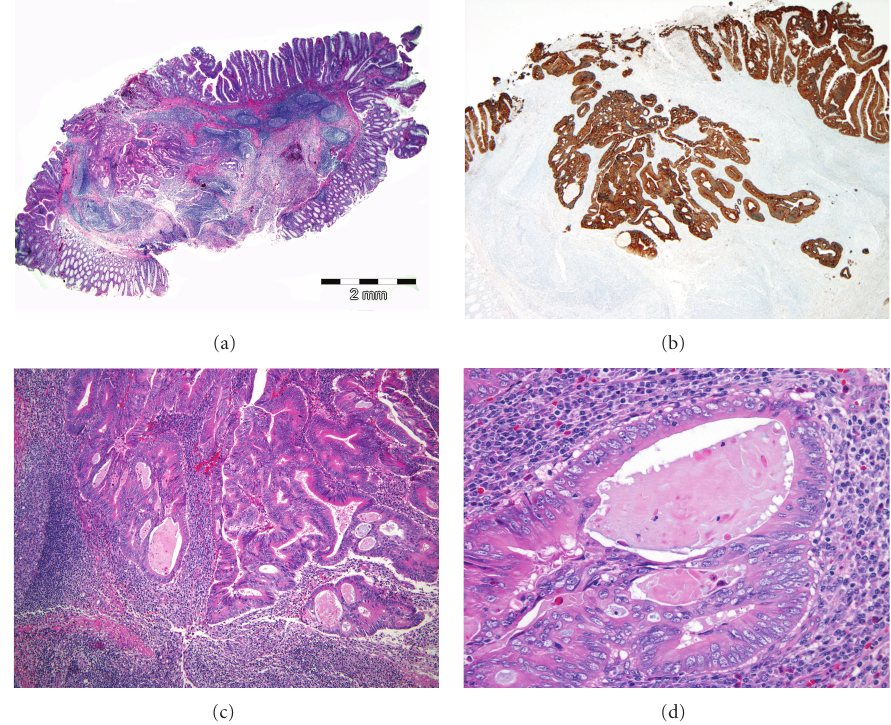
Figure 2: (a) Panoramic view of the tumor described. A well-demarcated tumor grows into the submucosa (hematoxylin-eosin, × 10). Overlying mucosa shows adenoma with high-grade dysplasia. Invasive adenocarcinoma associated with prominent lymphoid tissue encompassing several reactive germinal centres is observed in the submucosal layer. (b) Pan-Cytokeratin highlight tumor invasion. From the advancing edge few scattered foci of tumor budding arise (Cytocheratin AE1-3 × 20). (c) Histological architecture encompassing cystically dilated glands, in part cribriform arranged (hematoxylin-eosin, × 50). (d) The pink eosinophilic material filling the more dilated glands; a clear space separates the glandular epithelium from the intraglandular material (hematoxylin-eosin, ×